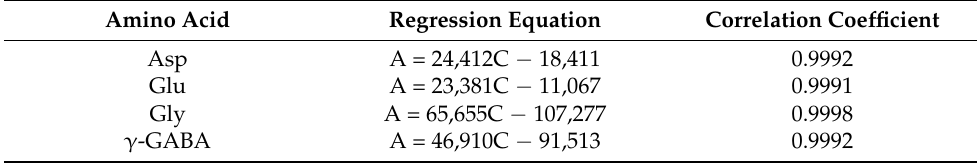
Table 1. Regression equations and correlation coefficients for Asp, Glu, Gly and γ -GABA. Amino Acid Regression Equation Correlation Coefficient Asp A = 24,412C − 18,411 0.9992 Glu A = 23,381C − 11,067 0.9991 Gly A = 65,655C − 107,277 0.9998 γ -GABA A = 46,910C − 91,513